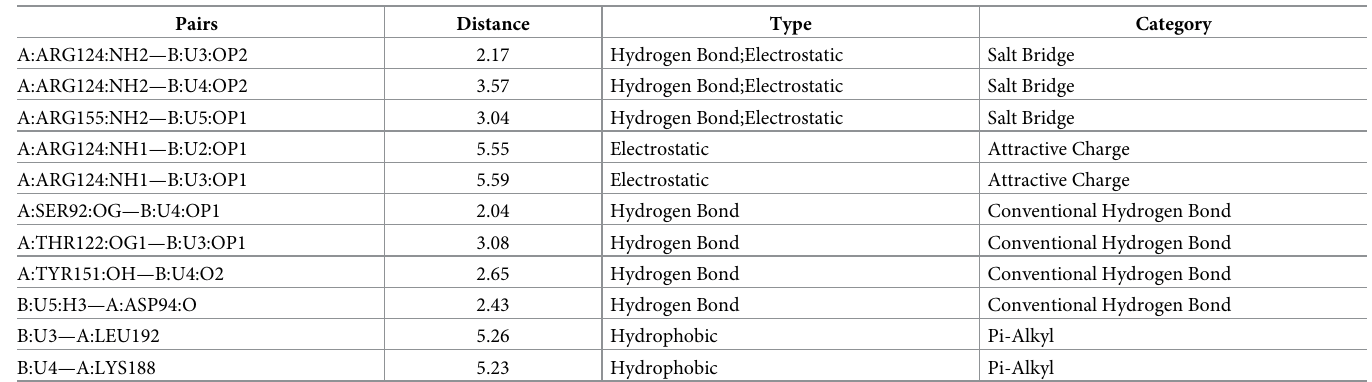
Table 2. Intermolecular contacts YBMV CP with RNA.